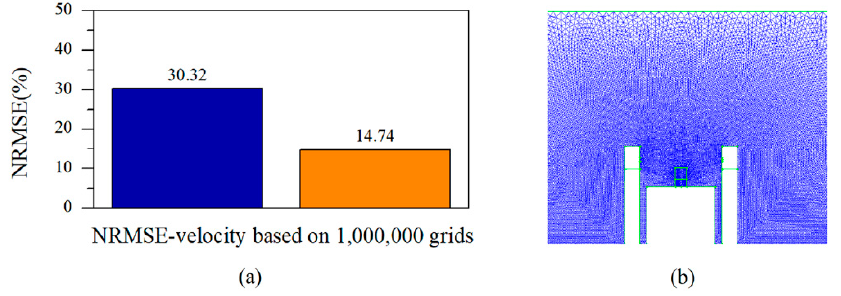
Figure 3. ( a ) NRMSE comparison between 410K/1000K grids and 770K/1000K grids; ( b ) Grid refine- ment with a 770K grid. refinement with a 770K